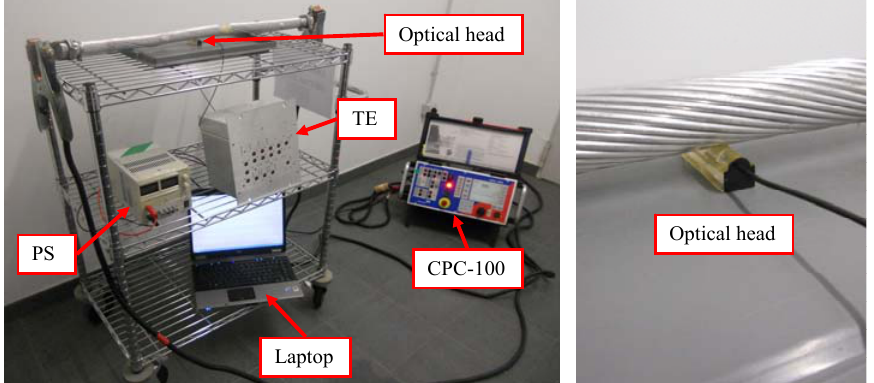
Figure 6. Test set-up of the low-cost optical current sensor ( Left ). Optical head detail ( Right ). TE: test equipment, including the electronic hardware for the acquisition inside.